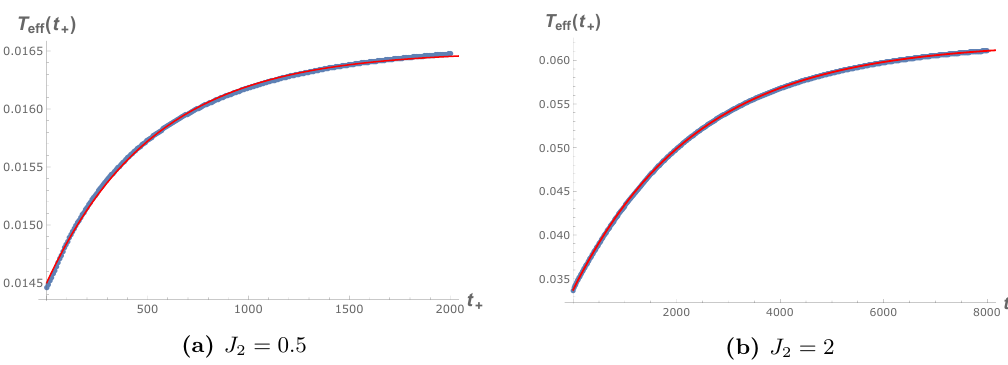
Figure 11. Thermalization of ( q = 2 , 4) SYK model. (a) The blue dots are the calculated effective temperature for the case of J 2 = 0 . 5 , J 4 = 1 as a function of t + . The initial inverse temperature is β i = 70 . The final inverse temperature is β f = 60 . 7 . The red curve is an exponential fit with 0 . 0165 − 0 . 0020 × e − 0 . 0019 t + . (b) The blue dots are the calculated effective temperature for the case of J 2 = 2 , J 4 = 1 as a function of t + . The initial inverse temperature is β i = 30 . The final inverse temperature is β f = 17 . 1 . The red curve is an exponential fit with 0 . 0620 − 0 . 0283 × e − 0 . 00042 t +